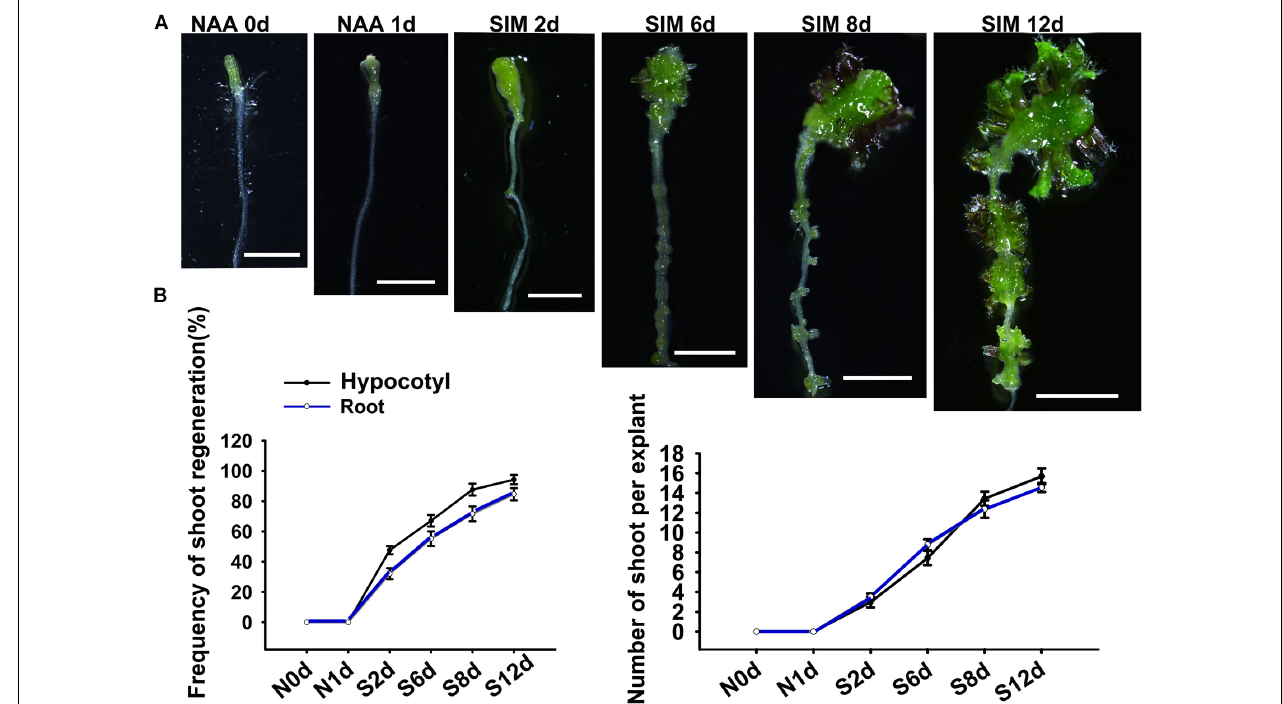
FIGURE 1 | The bi-directional shoot regeneration system. (A) Explants exposed to NAA treatment or incubated in SIM at different days. Scale bars represent 20 mm. (B) Frequency of shoot regeneration and regenerated shoot number per explant. Error bars represent the standard deviations of three biological replicates. For each replicate, more than 50 individual plants were